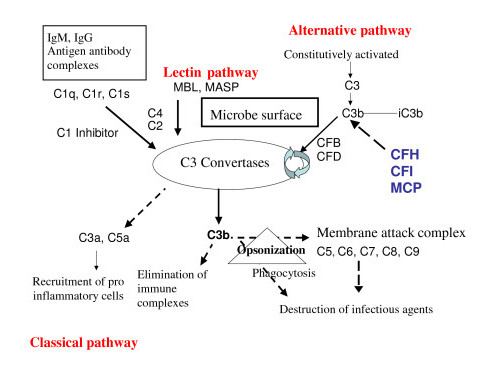
The 3 pathways of complement activation. Classical, lectin and alternative pathways converge at the point of C3 activation. The lytic pathway then leads to the assembly of the membrane attack complex which destroys infectious agents. Regulators of the alternative pathway CFH, CFI and MCP cooperate to inactivate endothelial cell surface-bound C3b, thus protecting endothelial cells from complement attack. CFH: factor H; CFI: factor I; CFB: factor B; CFD: factor D; MCP: membrane cofactor protein.